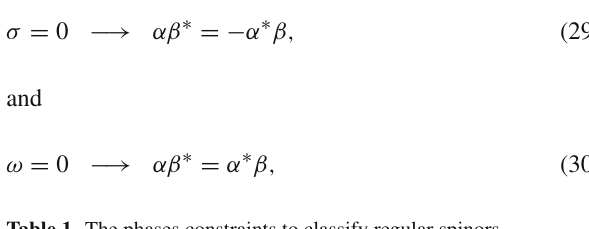
Table 1 The phases constraints to classify regular